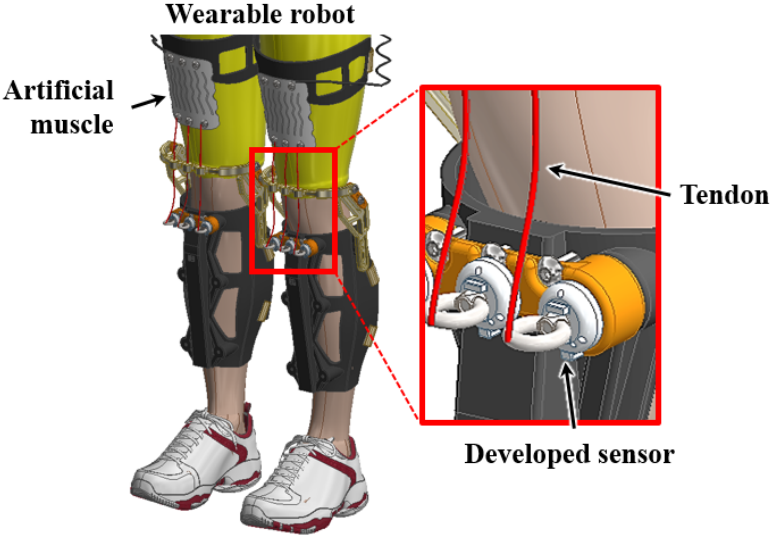
Figure 15. Conceptual assembly modeling of integration of the developed sensor and the wear- able robot.